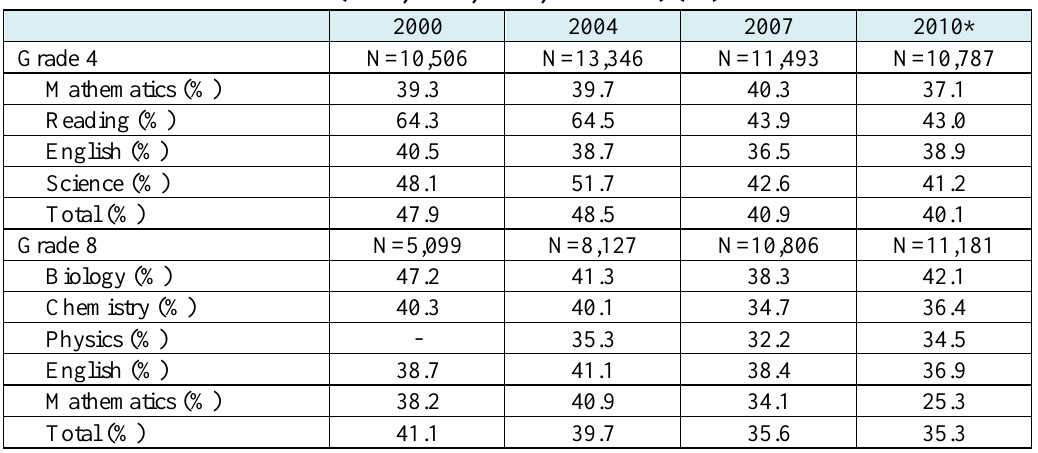
Table 4-10: Results of National Learning Assessment by Subject (Grades 4 and 8) (2000, 2004, 2007, and 2010)